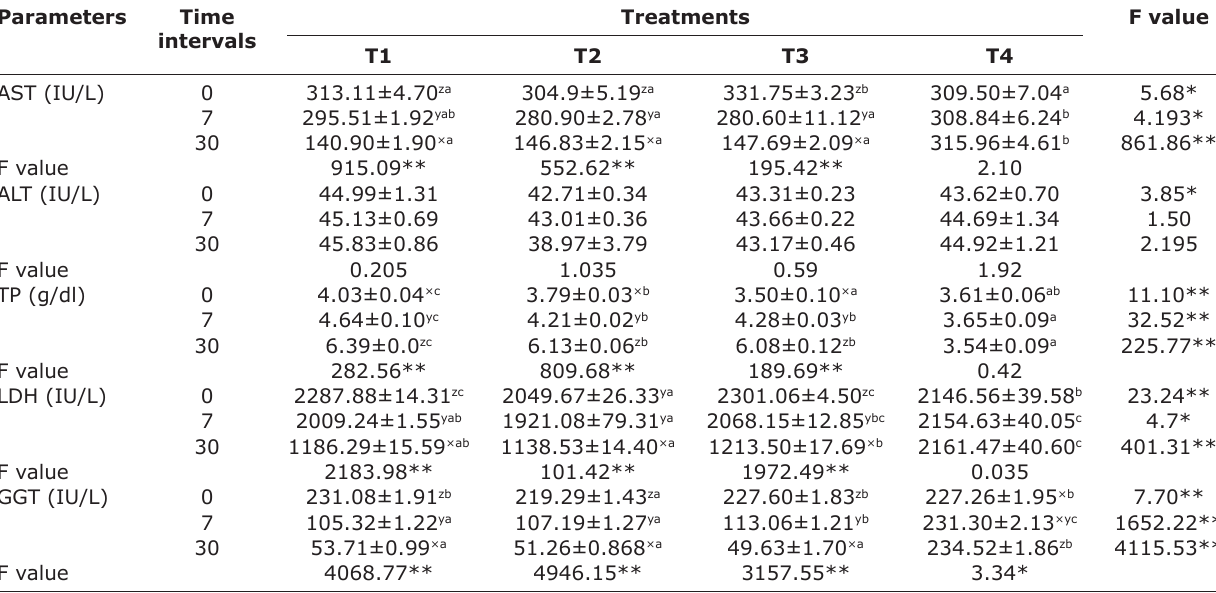
Table-3: Biochemical changes in various treatment groups at different time intervals in fasciolosis of goats.